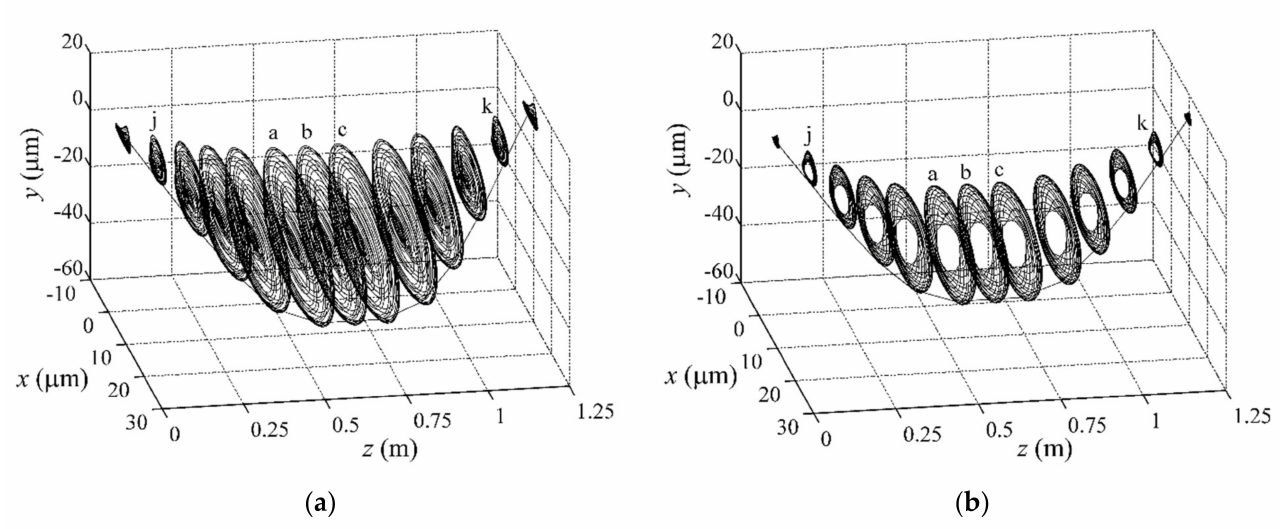
Figure 10. Quasi–periodic motions at each node on the axis for the flawed rod–disk and integral rotors. ( a ) Motions for the flawed rod–disk rotor; ( b ) Motions for the flawed integral rotor. Meanwhile, the comparison of dynamic motions and corresponding Poincar é maps are shown in Figure 11. Quasi–periodic orbits ensure Poincar é points to form a closed loop. As both orbits are identified as quasi–periodic motions, they have similar frequency components (Figure 12): working frequencies f ω ( f ω = ω /60); Hopf semi–frequency f H ( f H ≈ f ω /2), which is known as f ω /2 whirling; and another frequency, f QP , which comes from traditional quasi–periodic orbits. In addition, f ω = 138 Hz or 132.5 Hz for rod–disk rotor or integral rotor, and f H = 76